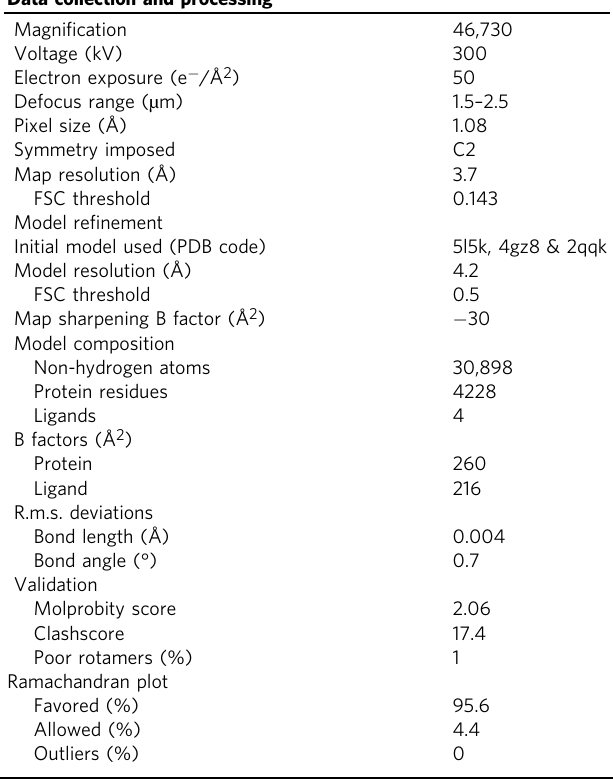
Table 1 Data collection and model re fi nement statistics. Data collection and